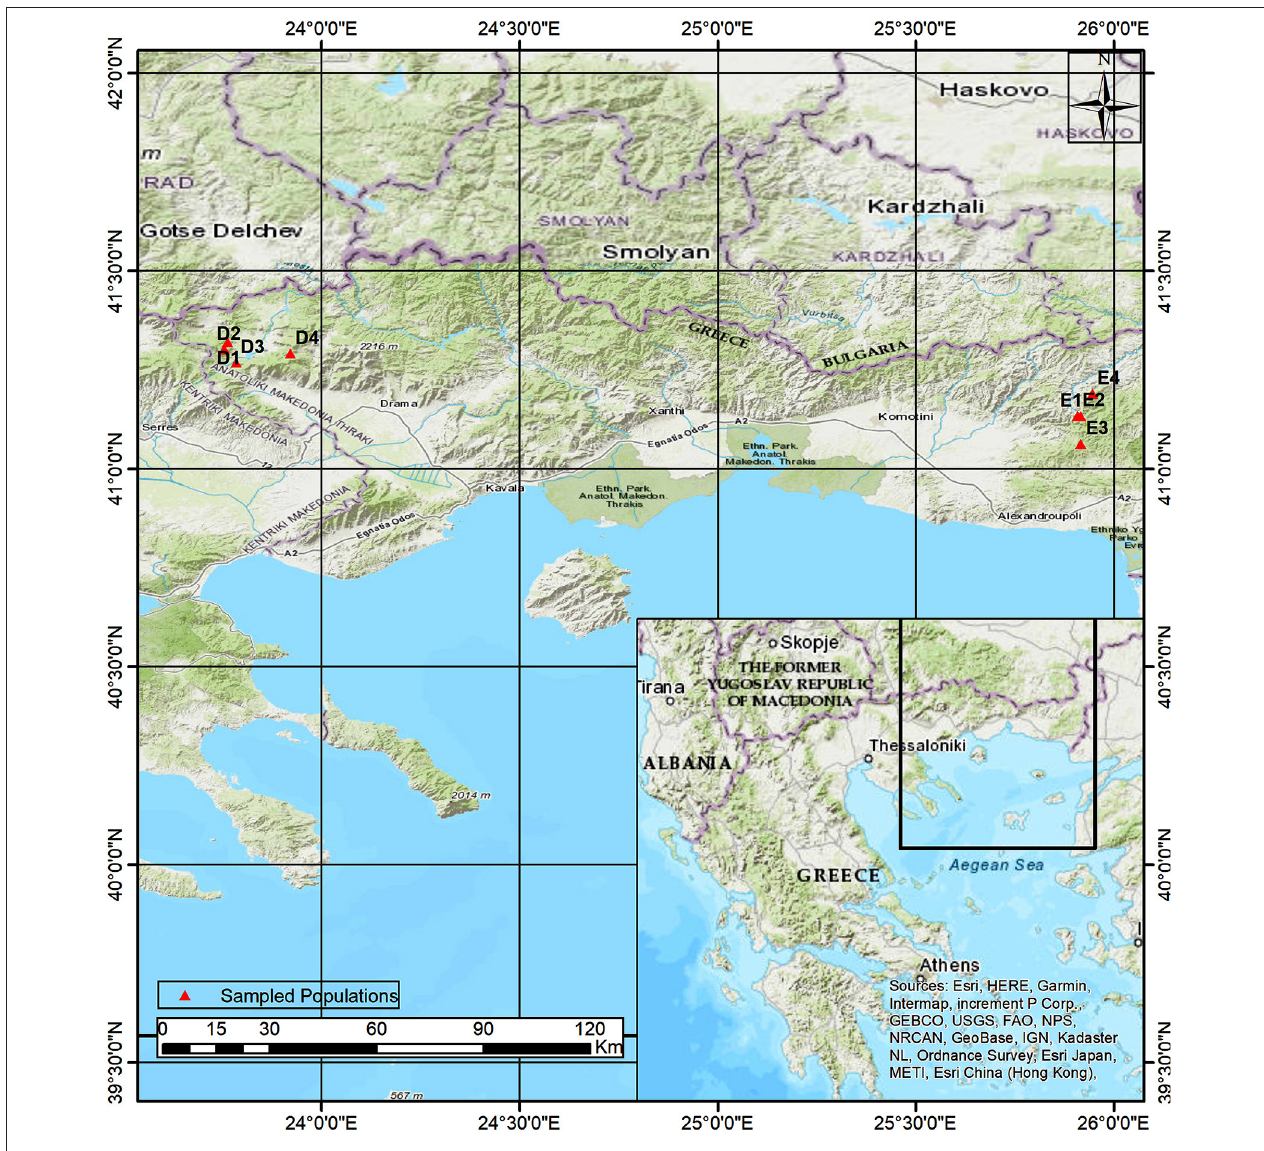
FIGURE 1 | Map of the area of